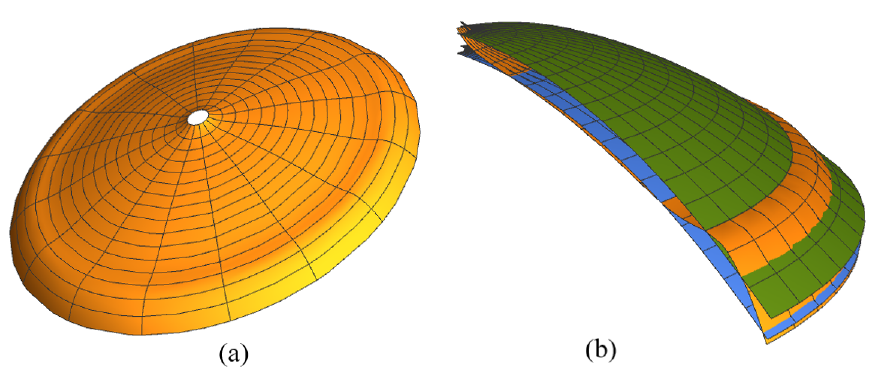
Figure 9. ( a ) Three-dimensional representation of the locus of the centers of axial forces: thrust surface; ( b ) axonometric section with the indication of the core thickness.